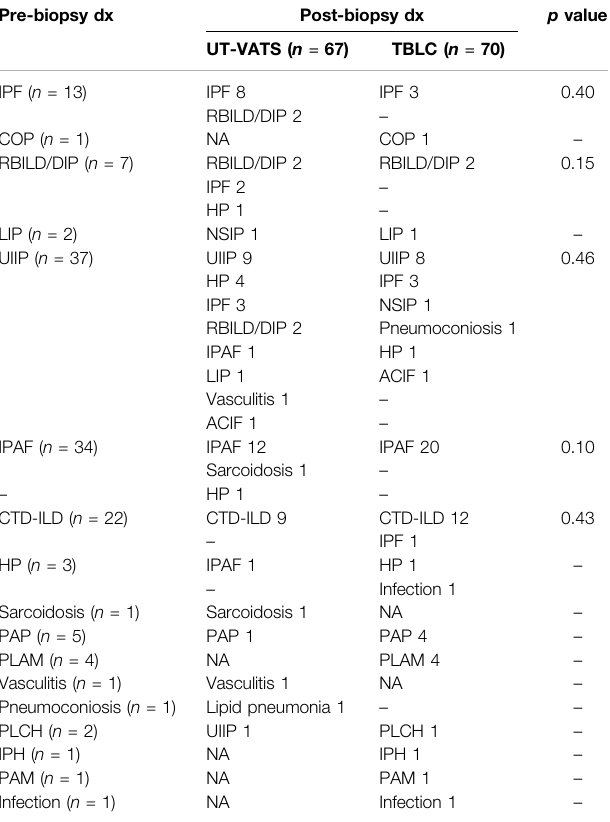
TABLE 2 | The alteration of MDD diagnosis after the addition of pathological